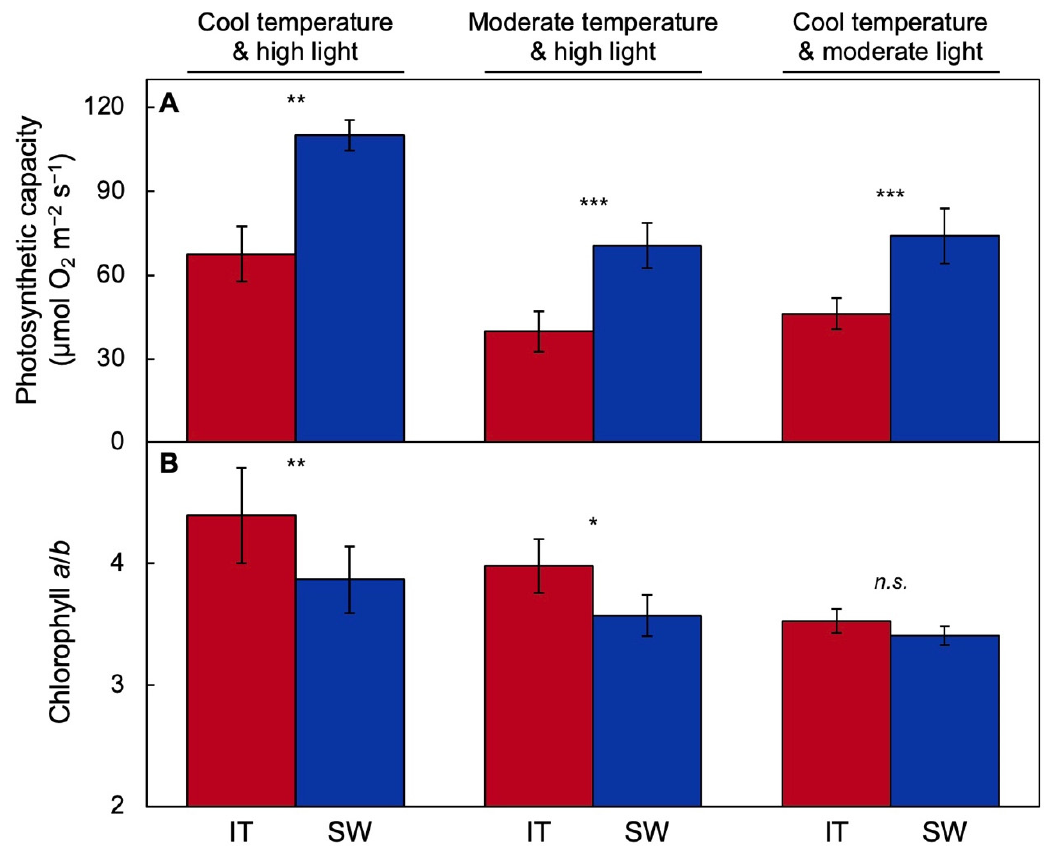
Figure 3. ( A ) Light- and CO 2 -saturated capacity of photosynthesis measured at 25 °C and ( B ) chlorophyll a / b ratio in IT (red columns) and SW (blue columns) plants grown under a cool temperature and high light (data from [52]), moderate temperature and high light (data from [59]), and cool temperature and moderate light (data from [24,57]). Mean values ± standard deviations ( n = 3 or 4); statistically significant differences between ecotypes based on Student’s t -tests are indicated with asterisks (* = p < 0.05; ** = p < 0.01; *** = p < 0.001); n.s. = not significantly different.